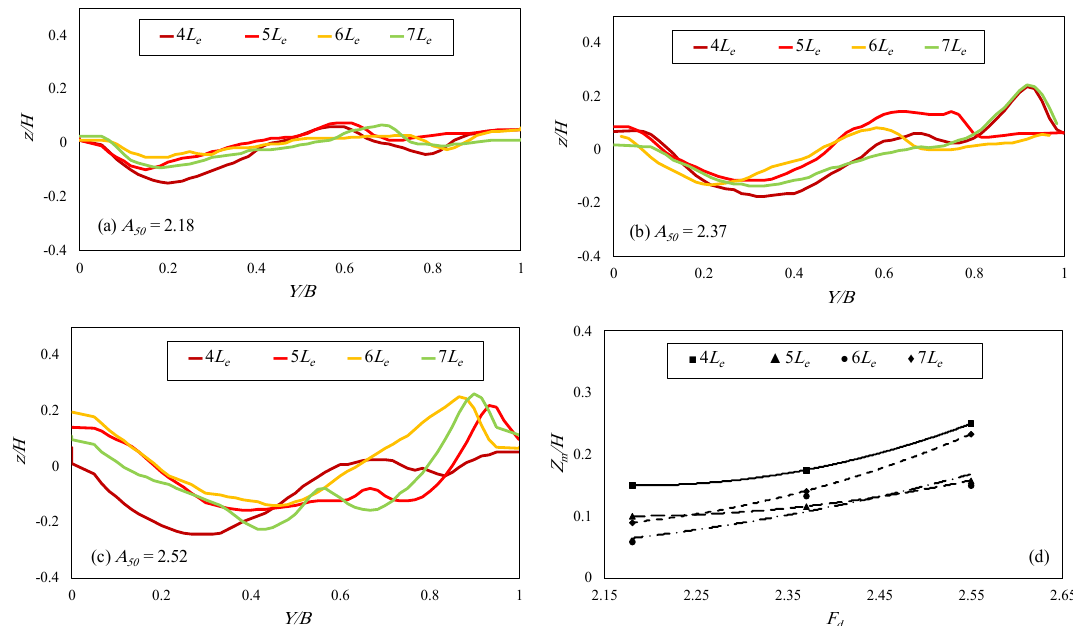
Figure 18. Cross sections of maximum thalweg depth and variations of maximum thalweg depth ( d ) at different distances and hydraulic conditions. ( a ) A 50 = 2.18 ( b ) A 50 = 2.37 ( c ) A 50 = 2.52.